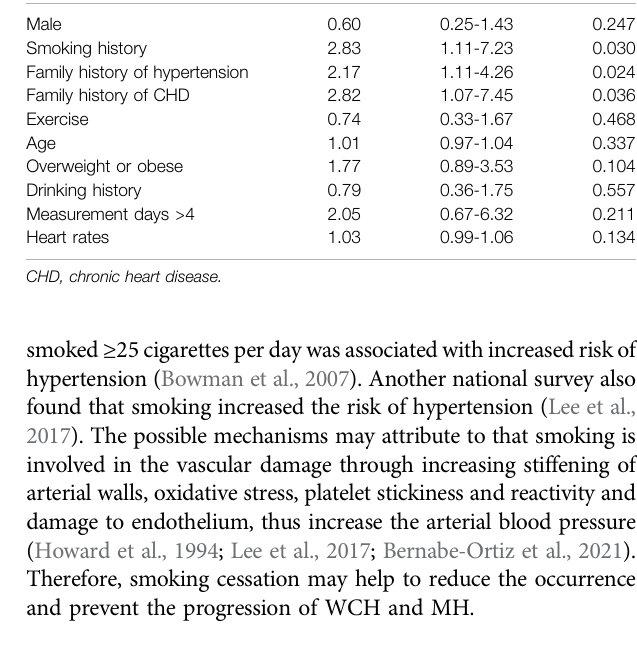
TABLE 2 | Multivariate logistic regression analysis for related factors in White coat hypertension. Variables